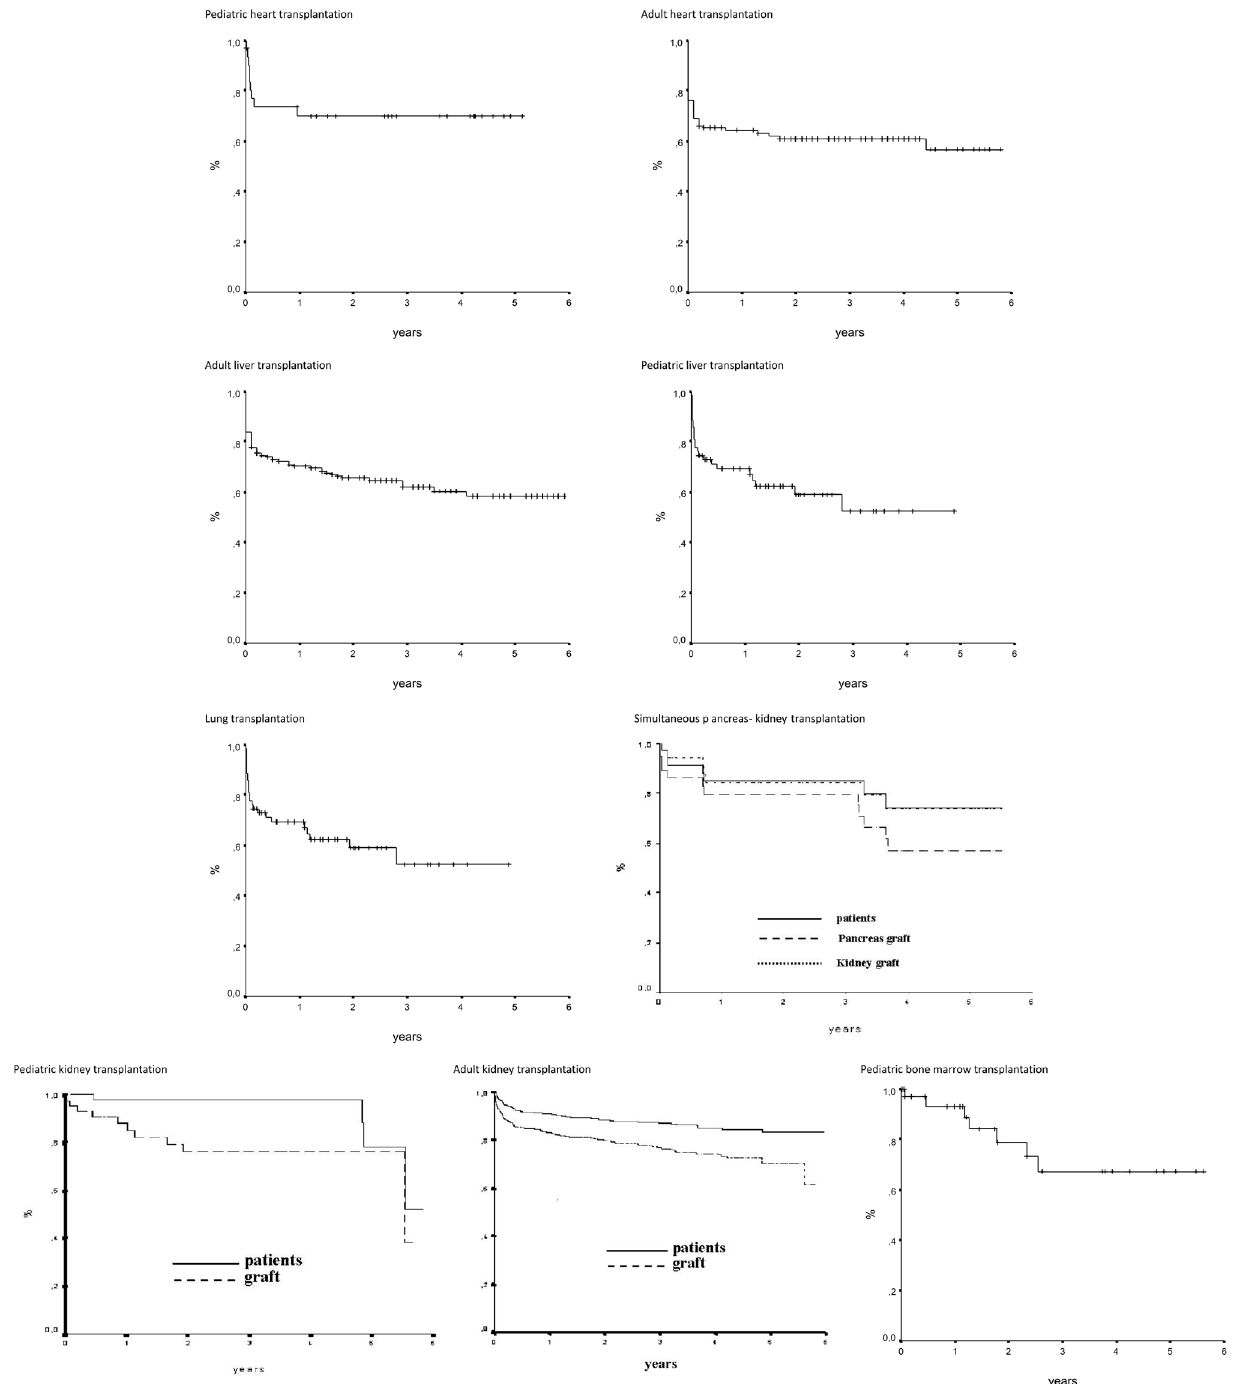
Figure 3 - Kaplan Meier survival curves - (2002 to 2007) Pediatric liver transplantation One hundred thirty five patients received liver transplants. The median age of recipients was 4 years (range, 7 months to 16 years). The indications for liver transplantation were biliary atresia in 75 patients (55%), alpha-1 antitrypsin